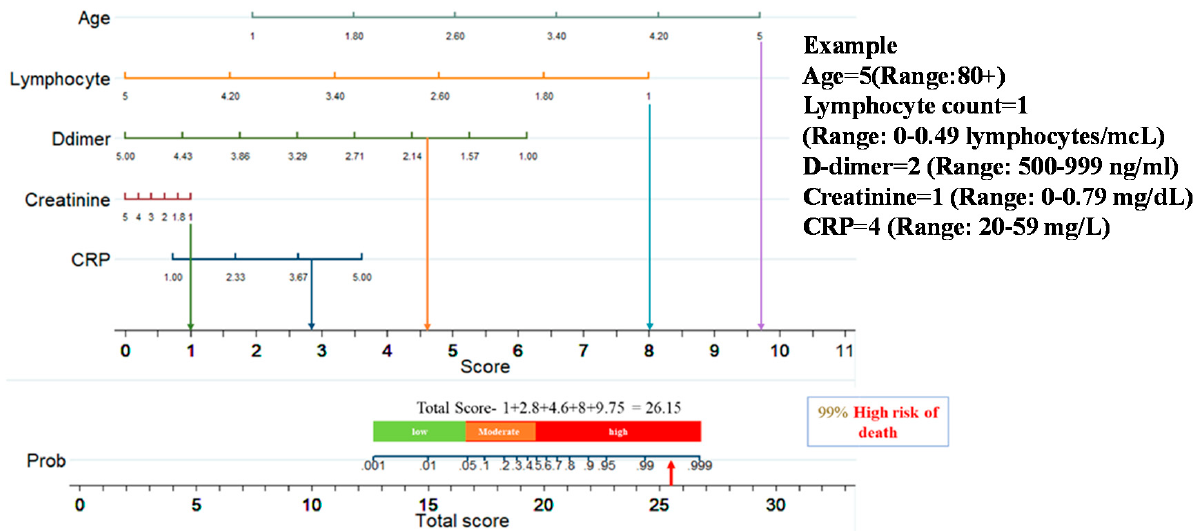
Figure 8. An example of nomogram-based ALDCC score to predict the probability of death of a patient from the test set (3 weeks before the actual outcome).